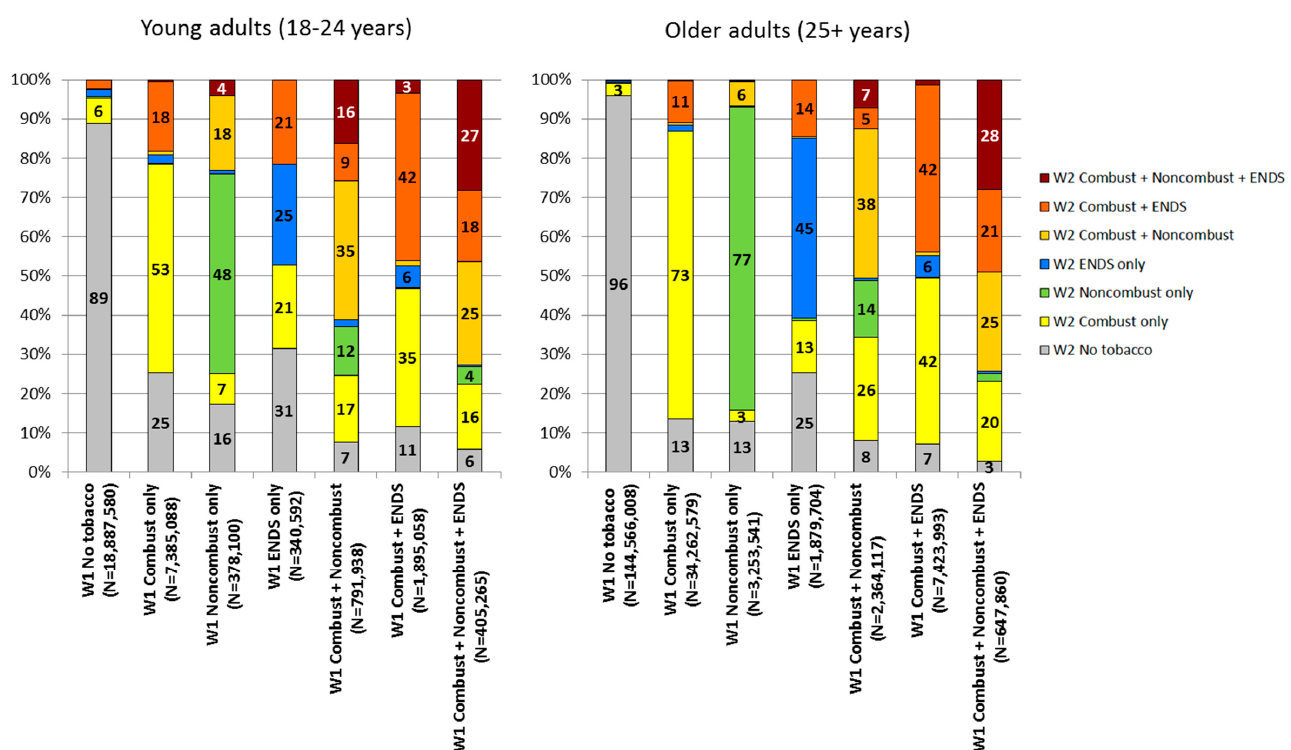
Figure 1. Transitions in current tobacco product use among young adults (aged 18-24 years) and older adults (aged 25+ years) in the United States: 2013–2014 to 2014–2015. Notes. Each bar in the figure represents a mutually exclusive tobacco product user group at Wave 1 (W1). N underneath each bar indicates the weighted population size for each tobacco product user group at W1 (i.e., the scale of the y-axis differs across bars). For each tobacco product user group at W1, transitions between W1 and Wave 2 (W2) are indicated by the colored distribution of each bar; for example, among the 18,887,580 young adult No tobacco users at W1, 89% continued No tobacco use at W2 and 6% transitioned to Combustible only use at W2. Current tobacco use defined as: for cigarettes, currently using everyday/somedays and smoked at least 100 cigarettes in lifetime; for hookah, currently using everyday/somedays/usually weekly/usually monthly; for all other products, currently using everyday/somedays. ‘Combustible’ includes cigarettes, traditional cigars, cigarillos, filtered cigars, hookah, pipe tobacco; ‘noncombustible’ includes smokeless tobacco, snus pouches, dissolvable tobacco; ‘ENDS’ includes e-cigarettes at each wave and e-products at W2. ‘No tobacco’ defined as no current use of any tobacco product. Estimates are suppressed when unweighted denominator <50 or RSE>30%; all estimates for ‘Noncombustible + ENDS’ are suppressed. Non-suppressed estimates <3 are not shown in the figure (for readability) but are shown in the appendix.